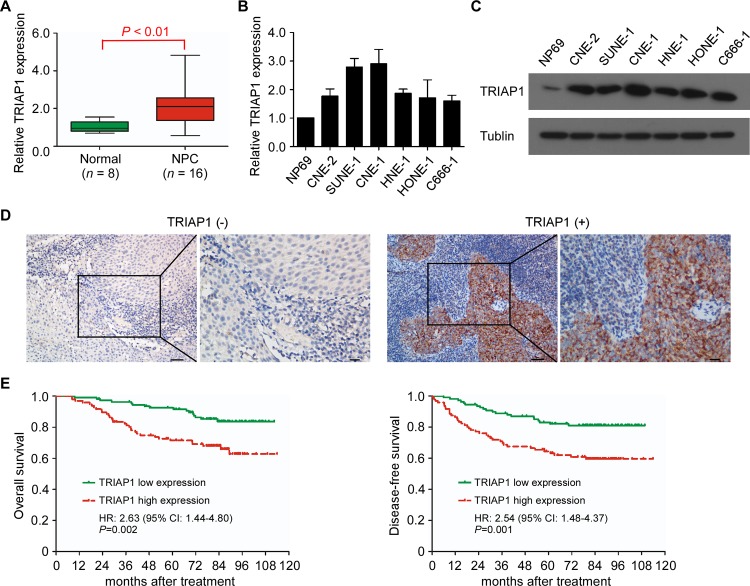
Upregulation of TRIAP1 correlates with poor survival in NPC patients.A and B, Quantitative RT-PCR analysis of TRIAP1 expression in normal nasopharyngeal epithelial tissues (n = 8) and NPC (n = 16) (A) and in immortalized NP69 cells and NPC cell lines (B). U6 was used as an endogenous control. Each experiment was independently repeated at least three times. The data are presented as the mean ± s.d. The P value was determined by Student’s t-test. (C) Representative western blotting analysis of TRIAP1 expression in immortalized NP69 cells and NPC cell lines. α-Tubulin served as a loading control. The experiment was independently repeated at least three times. (D) Representative immunohistochemistry (IHC) staining with low and high TRIAP1 expression. Scale bar, left panel 50 μm; right panel 20 μm. (E) Kaplan-Meier analysis of overall survival (left panel) and disease-free survival (right panel) for NPC patients with low (n = 108) versus high (n = 96) expression of TRIAP1. P value was determined using the log-rank test.